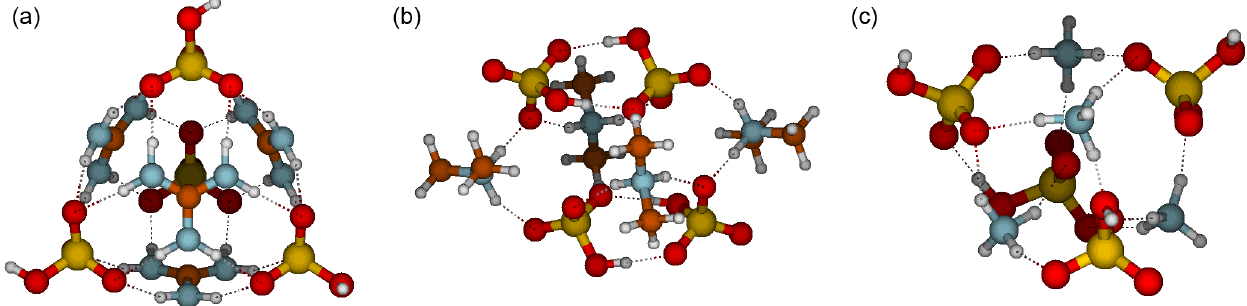
Figure 5. Molecular structures of clusters containing four sulfuric acid and four base molecules for guanidine (a) , dimethylamine (b) and ammonia (c) . Color coding: brown is carbon, blue is nitrogen, red is oxygen, yellow is sulfur and white is